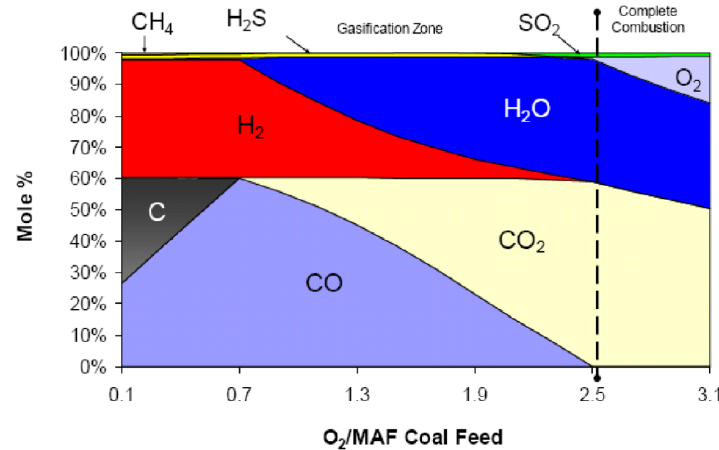
Figure 10. The products of oxidation reaction as a function of oxygen to coal ratio for gasification and combustion of Illinois #6 coal with dry feeding